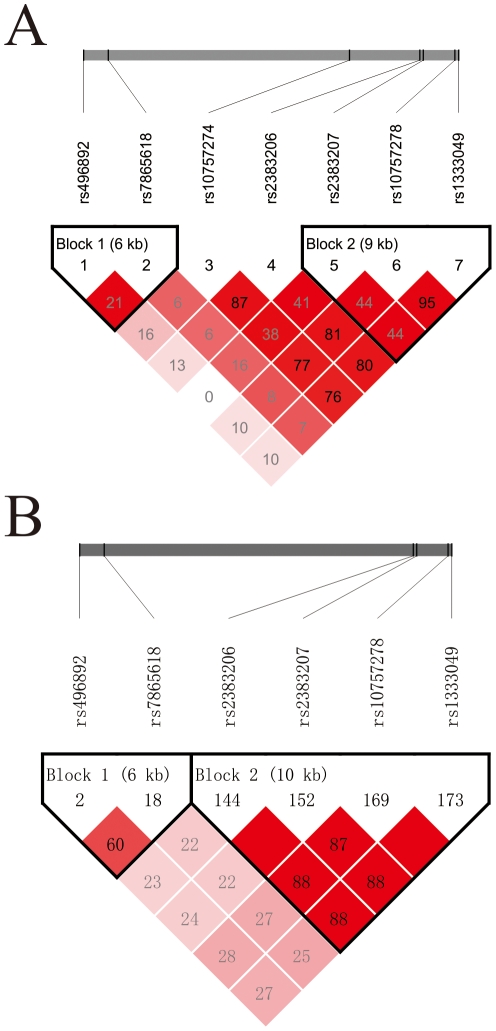
LD plot of SNPs in chromosome 9p21.3.(A) LD plot of seven SNPs in chromosome 9p21.3 of Chinese Han population from current study. The r2 values were estimated from data of 2,335 atherosclerosis patients and 1,078 controls enrolled in the current study; (B) LD structure of six risk SNPs at 9p21.3 in CEU population (Europeans) from the data of HapMap phaseII release 23. We constructed the plot with Haploview 4.2 [47], and r2 (×100) values were depicted in the diamonds. Blocks were determined using the default method of Gabriel et al
[48].